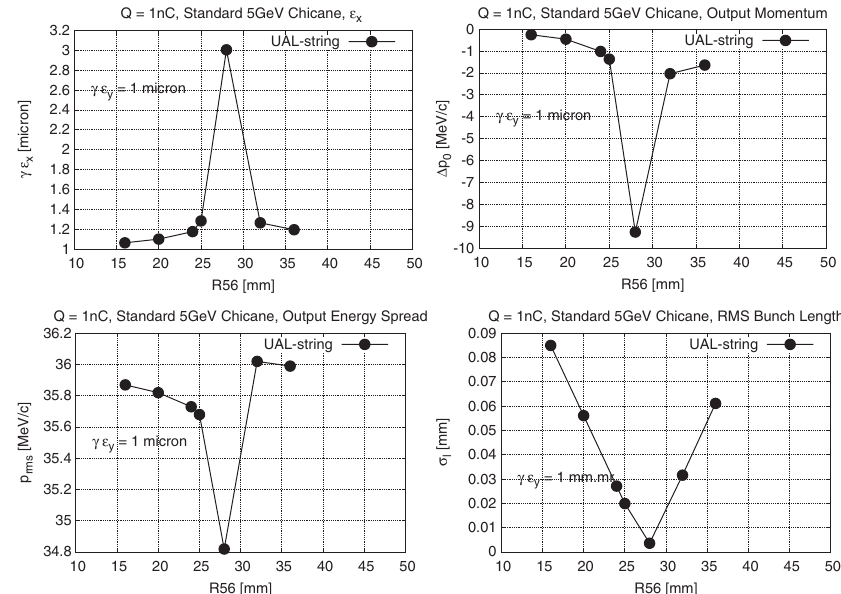
FIG. 16. Dependence on R electron bunch shape was Gaussian gridded, the string length was l